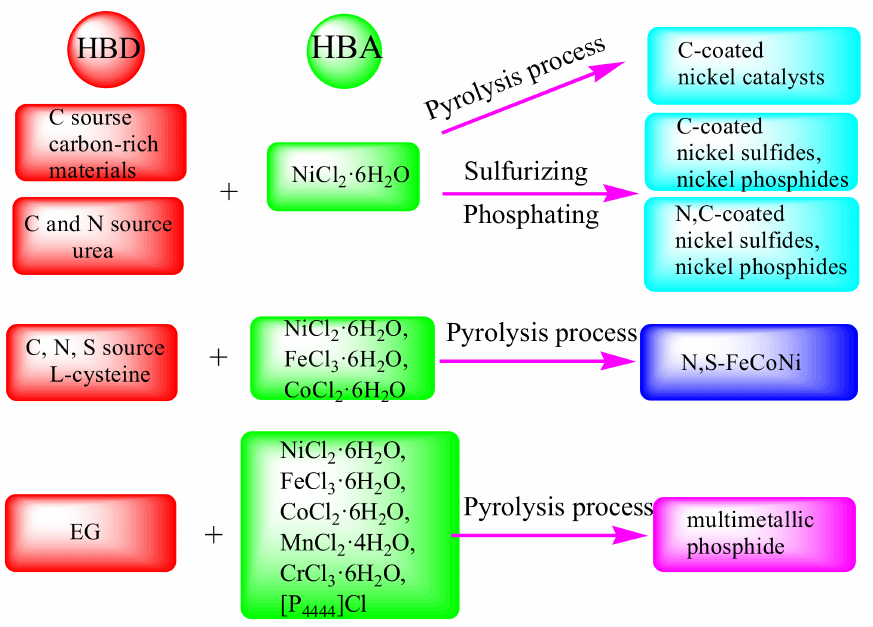
Figure 6. Schematic diagram of the “all-in-one” strategy to prepare heteroatom-doped nickel-based catalysts through designing composition of DESs